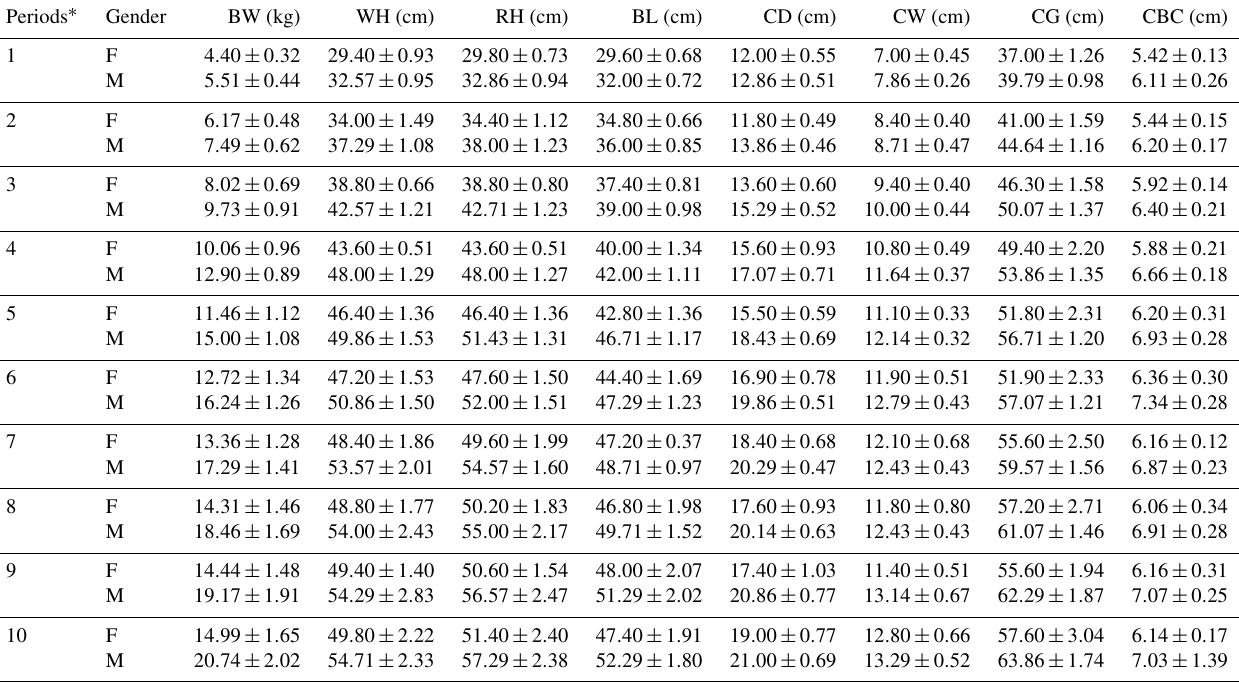
Table 5. Periodic mean values ( X ± Sx ) of some body trait measures in Angora goat kids.